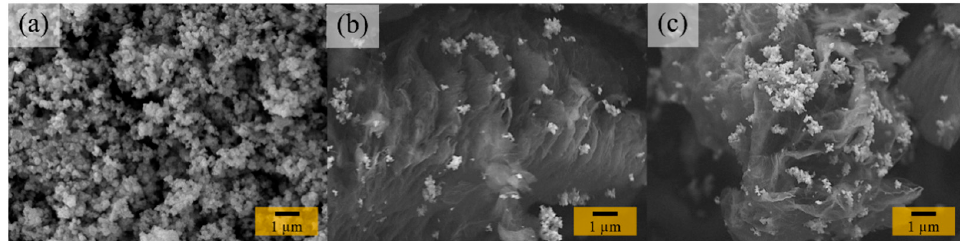
Figure 5. FE-SEM images of preparative materials; ( a )GeNPs, ( b )10Ge/NrGO, and (c)20Ge/NrGO.